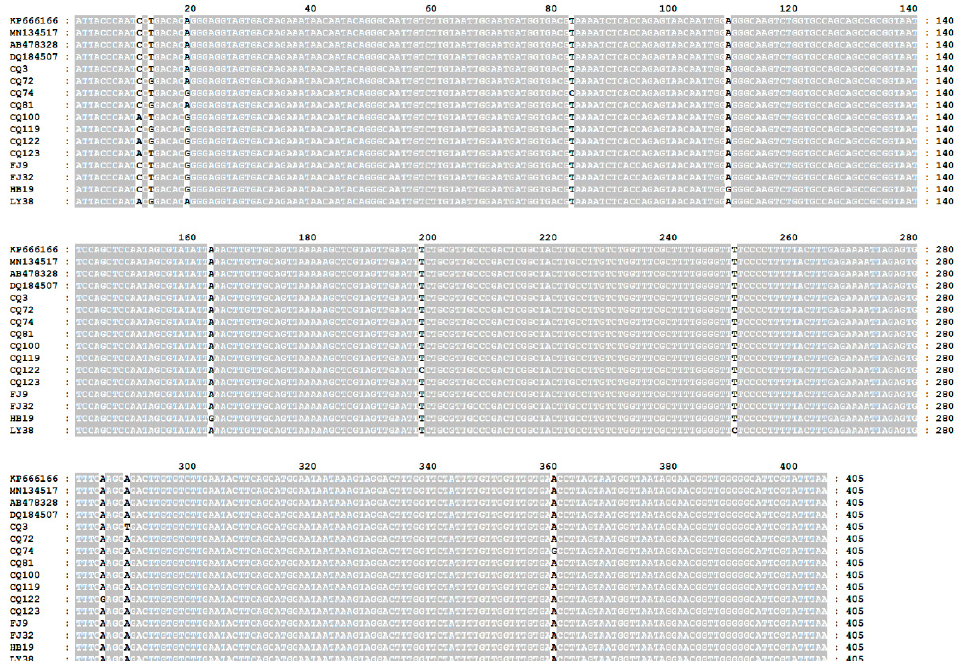
Figure 2. Multiple sequence alignments of B. gibsoni in cats in China. The sequences obtained from this study were compared with the related sequences deposited in GenBank, KP666166 (China),